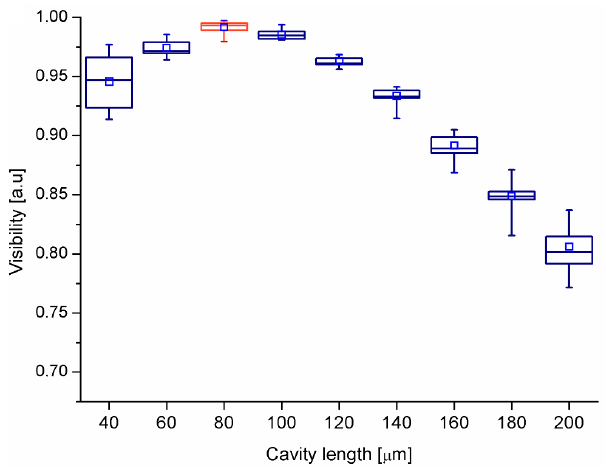
Figure 5. Visibility value as a function of cavity length measured on NDD. The straight lines inside the boxes indicates a median and the squares inside show an average value based on all measurement series.